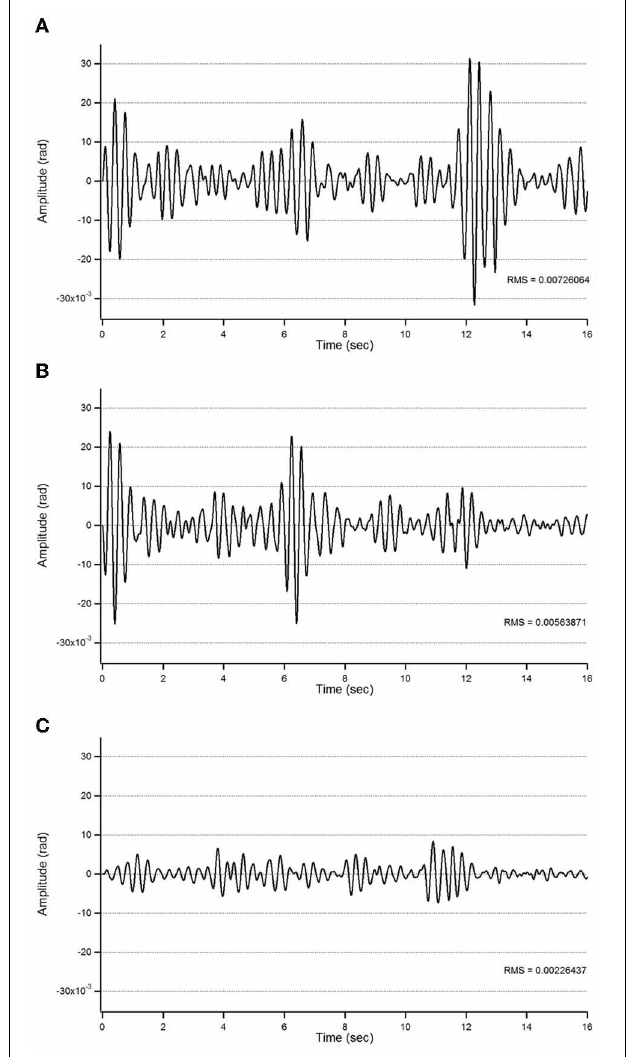
FIGURE 5 | Action tremor in the bandwidth 2.5–3.5Hz in patient 1 in the 3 experimental conditions (A: basal; B: post-sham; C: post-tCCDCS) as a function of time (expressed in